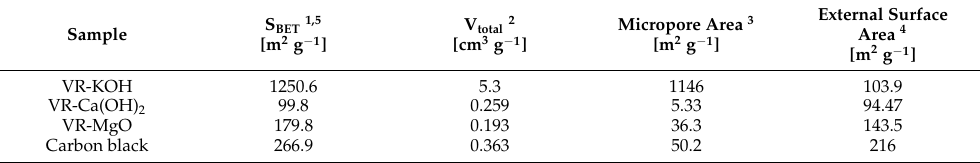
Table 1. N 2 -physisorption analysis data.